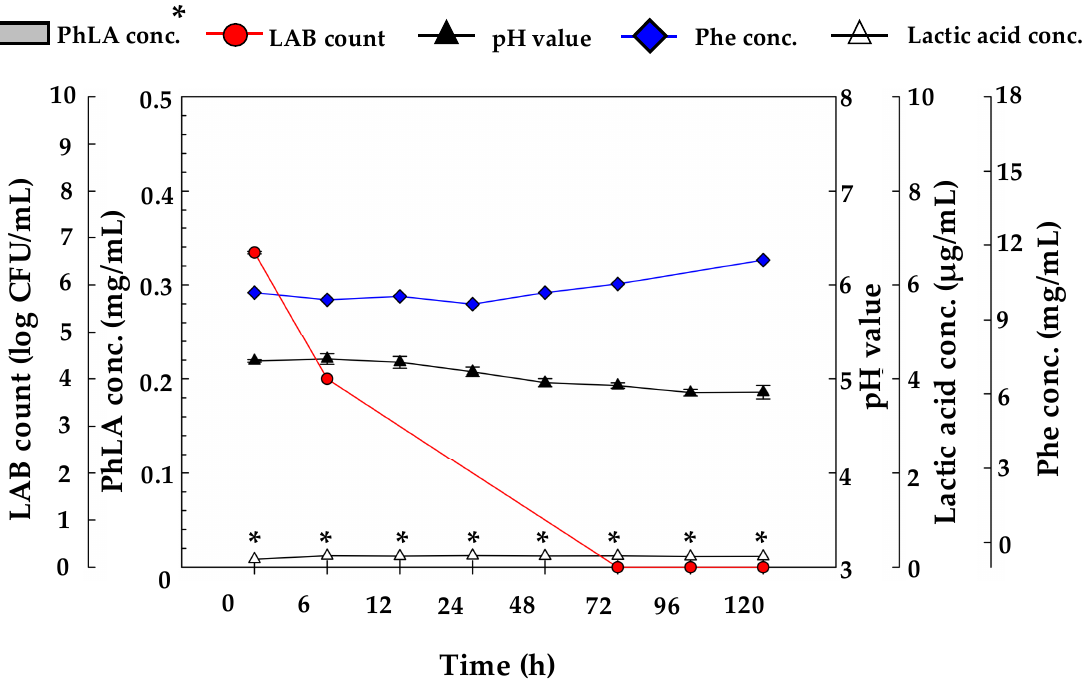
Figure 5. After pretreatment of Porphyra residues with commercial cellulase (4000 U), the LAB count, pH value, and concentration of PhLA, lactic acid, and Phe of Porphyra residues (2%) with the addition of UF < 100 kDa (8.21%),